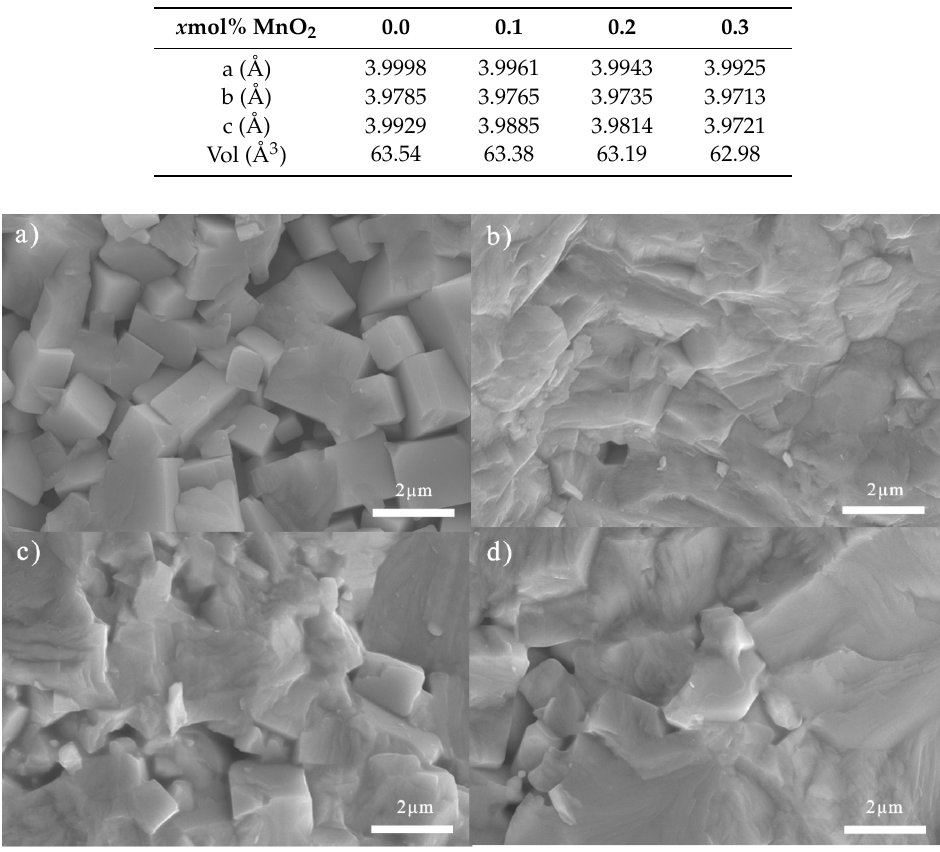
Figure 2. SEM of KNLNT- x Mn ( a ) x = 0.0, ( b ) x = 0.1, ( c ) x = 0.2, ( d ) x = 0.3 ceramics sintered at 1178 °C, 1126 °C, 1128 °C and 1132 °C, respectively.